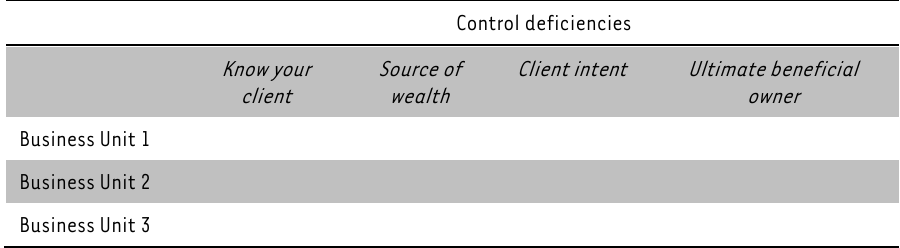
TABLE 1: Template of ‘who’ assessment of reputational risk